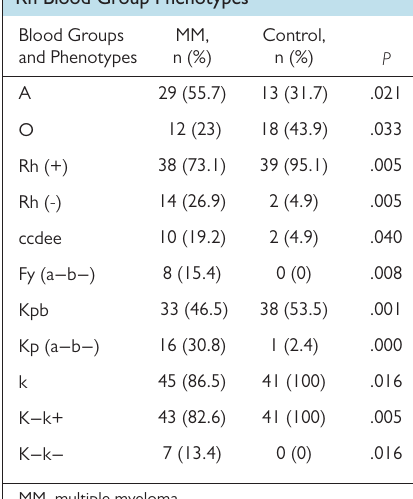
Table 4. Significant Differences Between MM and Control Groups in Terms of ABO, Rh, Kell, Duffy, C, c, E, e Blood Groups and Duffy, Kell, Rh Blood Group Phenotypes Blood Groups and Phenotypes